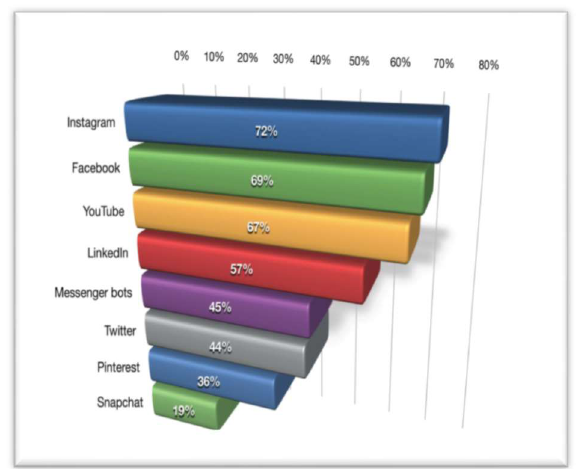
Figure 1. Social media platforms marketers want to learn more about